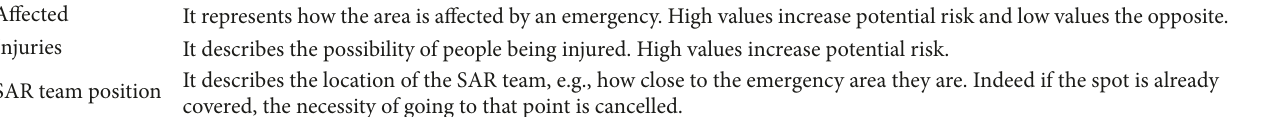
Table 2: Emergency factor inputs.